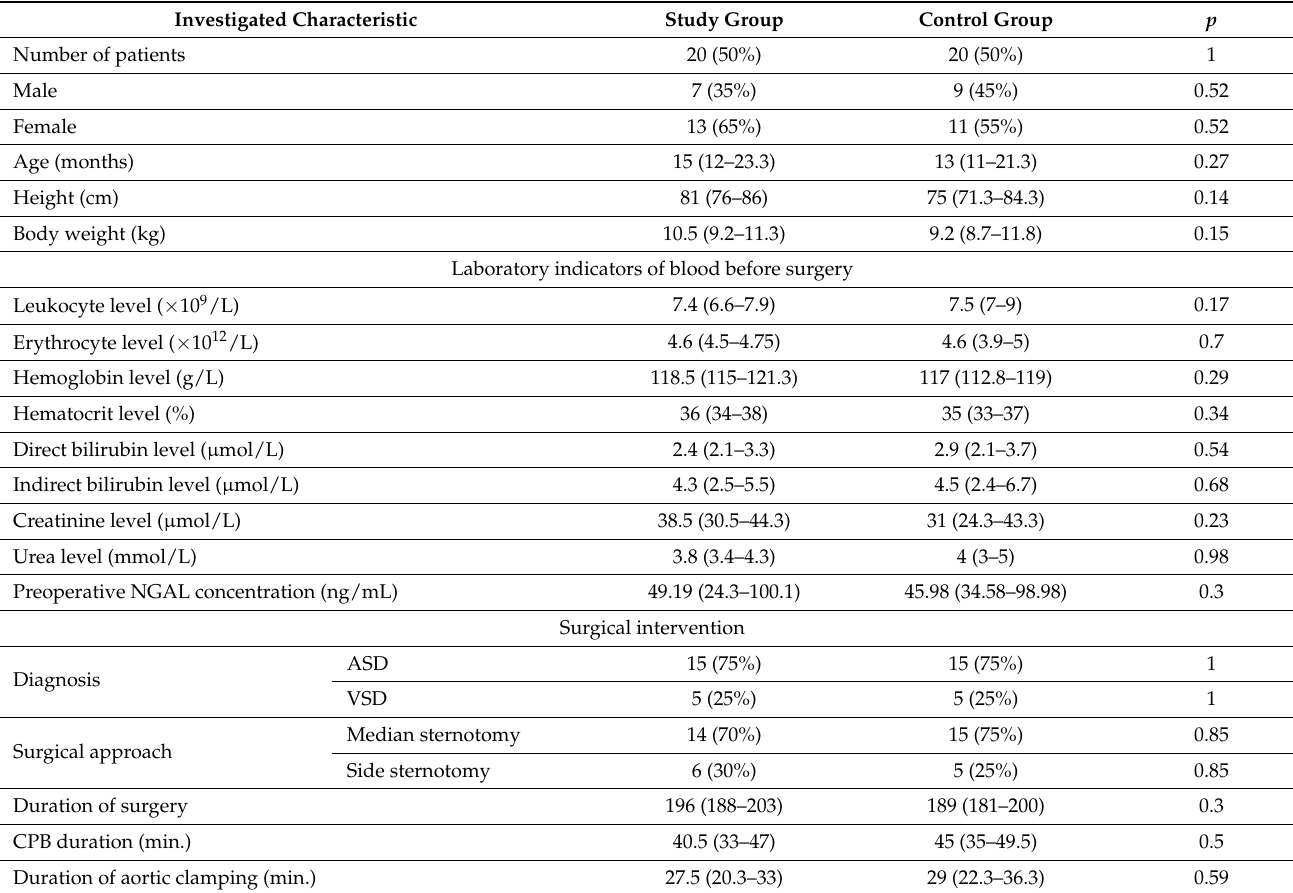
Table 1. Characteristics of the studied patient